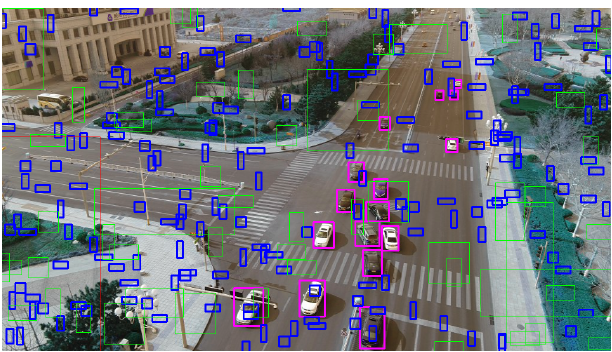
Figure 4. Negative Sample Results of Random